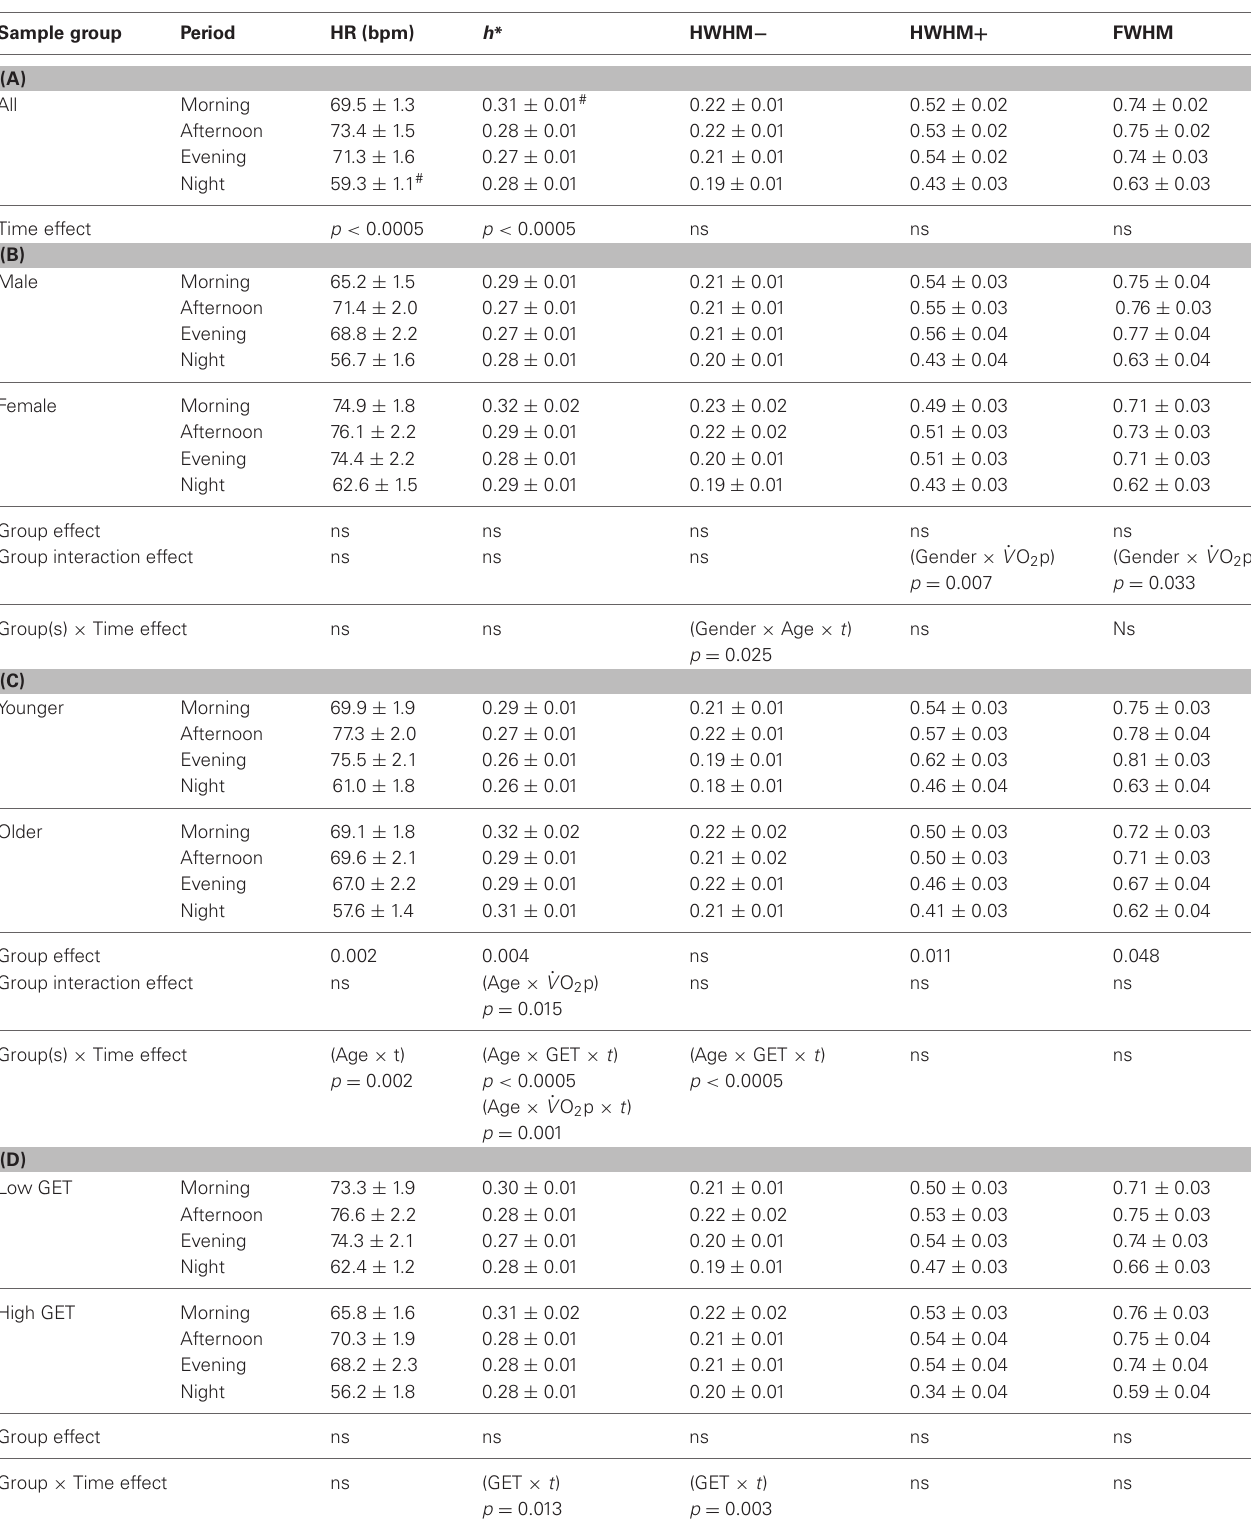
Table 2 | Heart rate and multifractal singularity spectrum parameters as a function of “time of day”: (A) for the whole group and for (B) “gender,” (C) “age” and (D,E) “fitness” sub-groups. Sample